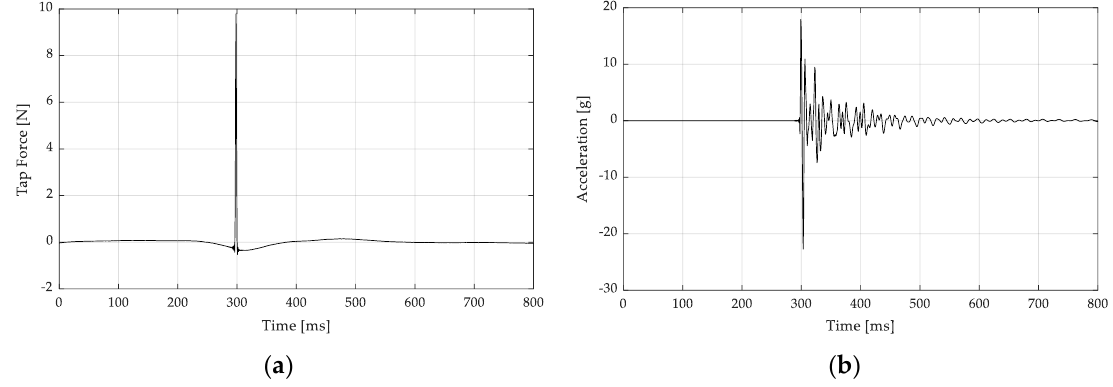
Figure 3. Input and response locations for the hammer tap test. Accelerometers are placed on the backside of parts. ( a ) Door panel. ( b ) Beam extracted from door panel.